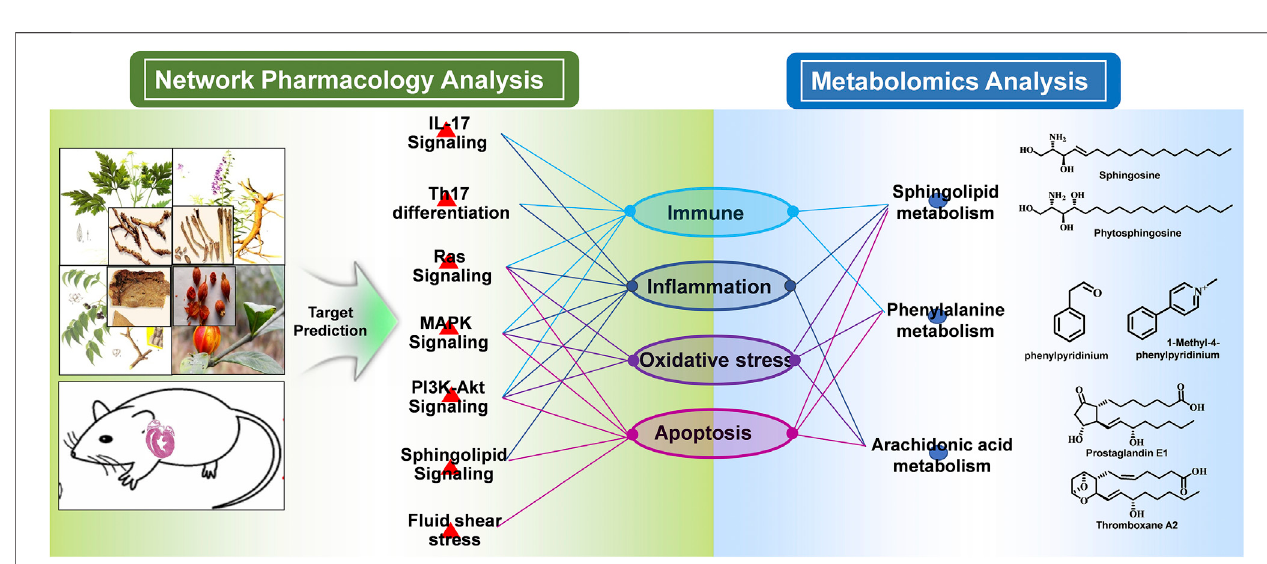
FIGURE9| Integratedmechanismofnetworkpharmacologyandmetabolomicanalysis.Themainsignalingpathways,differentiallyregulatedmetabolites,andmetabolicpathwayswere combinedlogicallythroughthebiologicalfunctions.Fromthepathwayperspective,theHLJDTtargetsweresigni fi cantlyenrichedinsevenpathwaysincludingTh17differentiation,IL-17,RAS, MAPK,Pi3k-Akt,sphingolipid,and fl uidshearstresssignalingpathways,whichwerecriticalintheregulationoftheimmune,in fl ammation,oxidativestress,andapoptosisprocessassociated with MI. From the metabolomics perspective, the GO and KEGG pathway enrichment analysis of the differential metabolites revealed consistent results. In summary, network pharmacology analysis suggested that HLJDT could act as an immunomodulatory, anti-in fl ammatory, antioxidant stress, and anti-apoptotic agent to exert anti-MI effects.